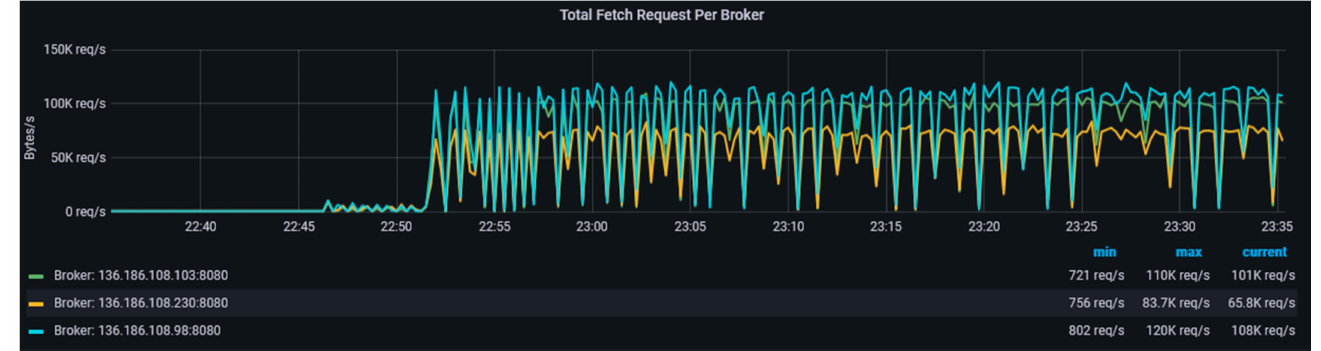
Figure 10. Frequency of requests to produce, consume per